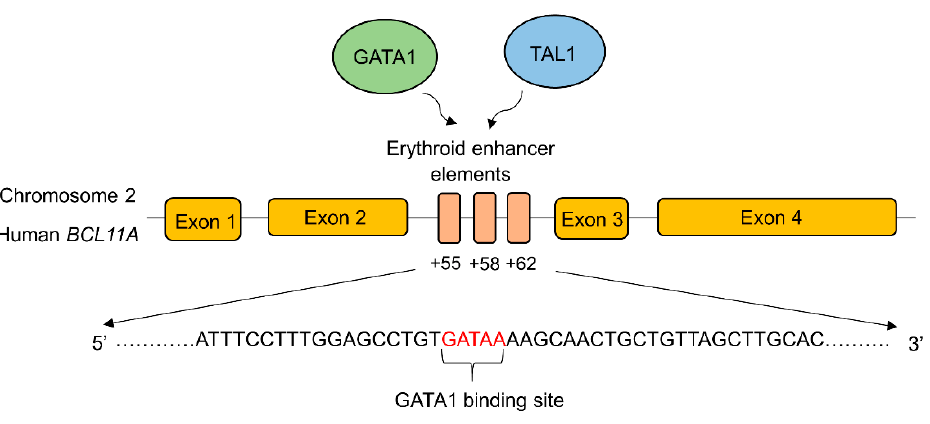
Figure 2. Schematic depiction of the transcription factor binding sites in the erythroid enhancer region of BCL11A. The binding of transcription factors (GATA1, TAL1) increases the BCL11A expression resulting in decreased γ -globin gene expression. Disruption of the erythroid-specific enhancer of BCL11A increased the endogenous expression of γ -globin and HbF production in adults. This approach is identified as an effective therapeutic strategy to treat β -hemoglobin disorders [96]. GATA1; GATA binding protein 1, TAL1; T-cell acute lymphoblastic leukemia 1. The major transcriptional activators of BCL11A , GATA1, and TAL1 bind to the erythroid enhancer elements in intron 2.